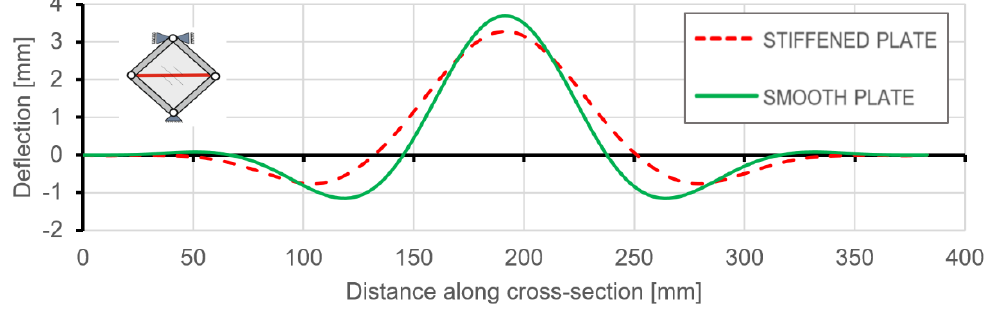
Figure 20. Comparison of horizontal cross-section deflections at the load level causing the start of plastic deformation (q = 37 N/mm).